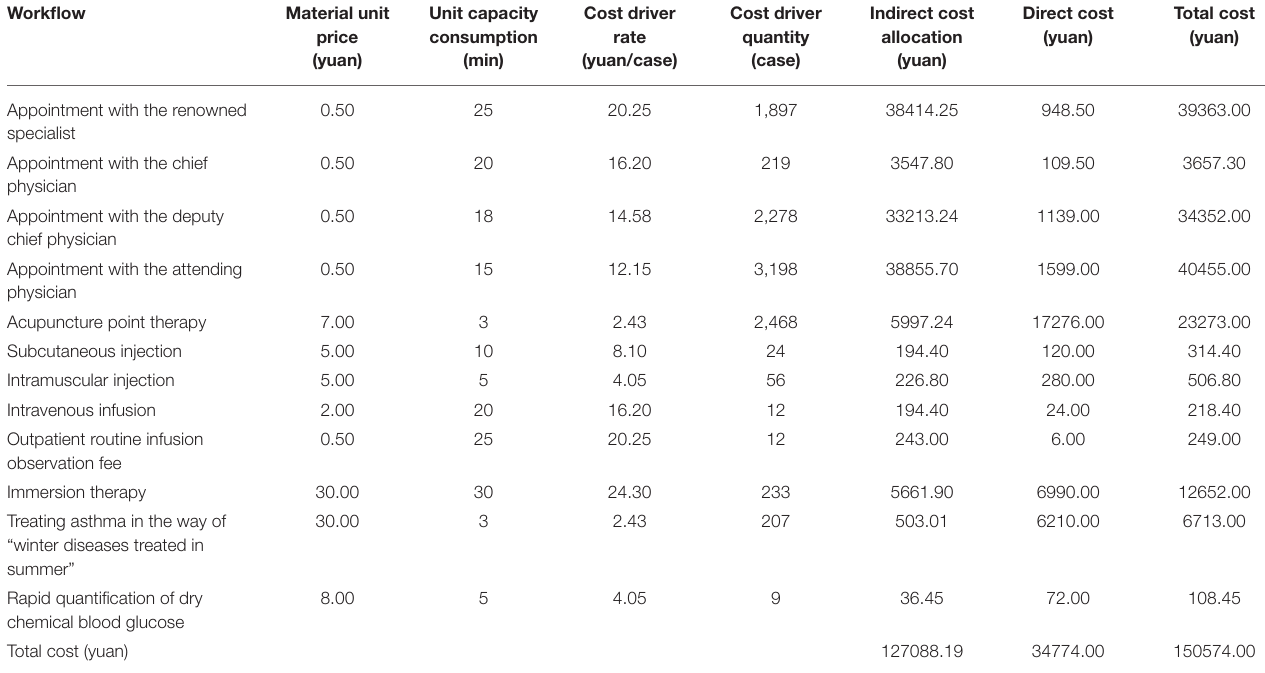
TABLE 6 | Final cost of each operation in TCM